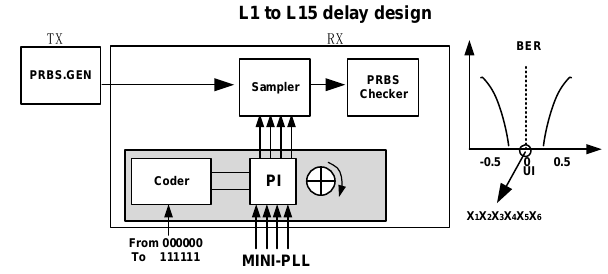
Figure 5. δ on L0 to L15.